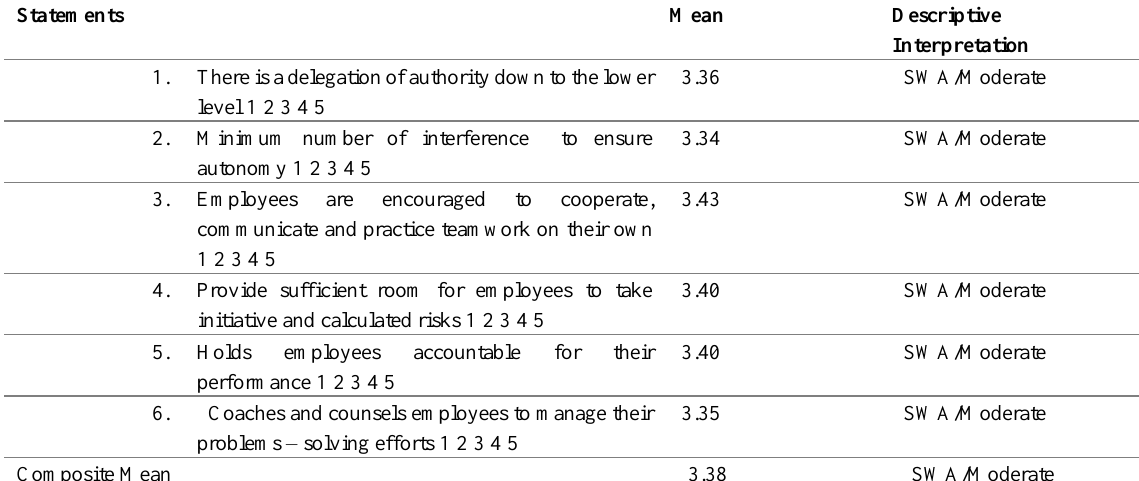
Table 3: Organizational Climate Along with